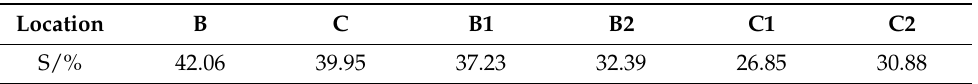
Table 5. Similarity comparison between Mt. Changbai, its branches, and five other investigation sites.